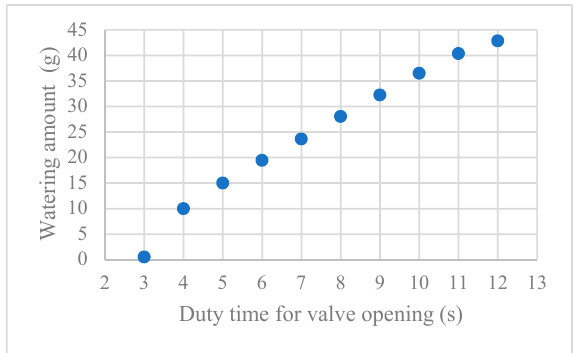
Figure 26. Relationship of duty time for valve opening (3 to 12 s) and watering amount.